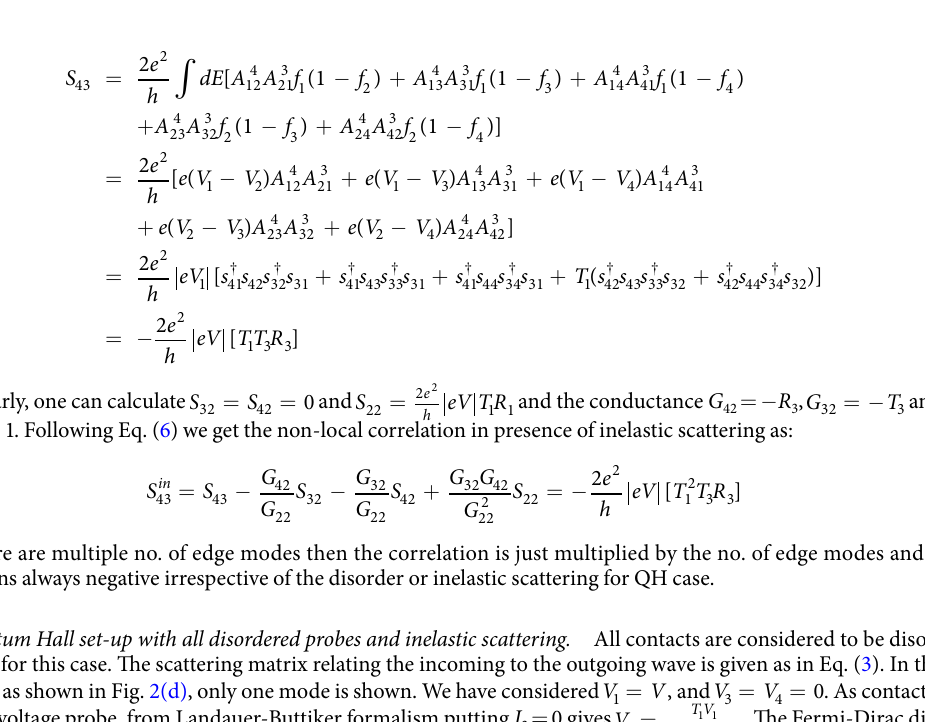
Figure 3. Non-local correlation in quantum Hall case S in vs R 3 for all disordered probes with inelastic scattering 43 with parameters = = = . R R R 0 5 (solid line) and = = . = . R R R 0 9, 0 8 (dashed 1 2 4 1 4 2